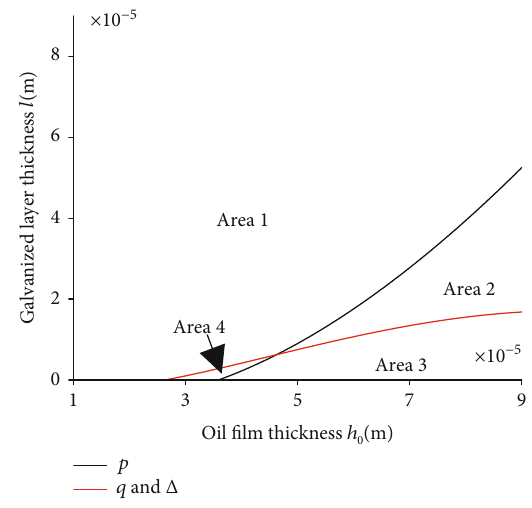
Figure 11: Positive and negative boundary of p , q , and △ .